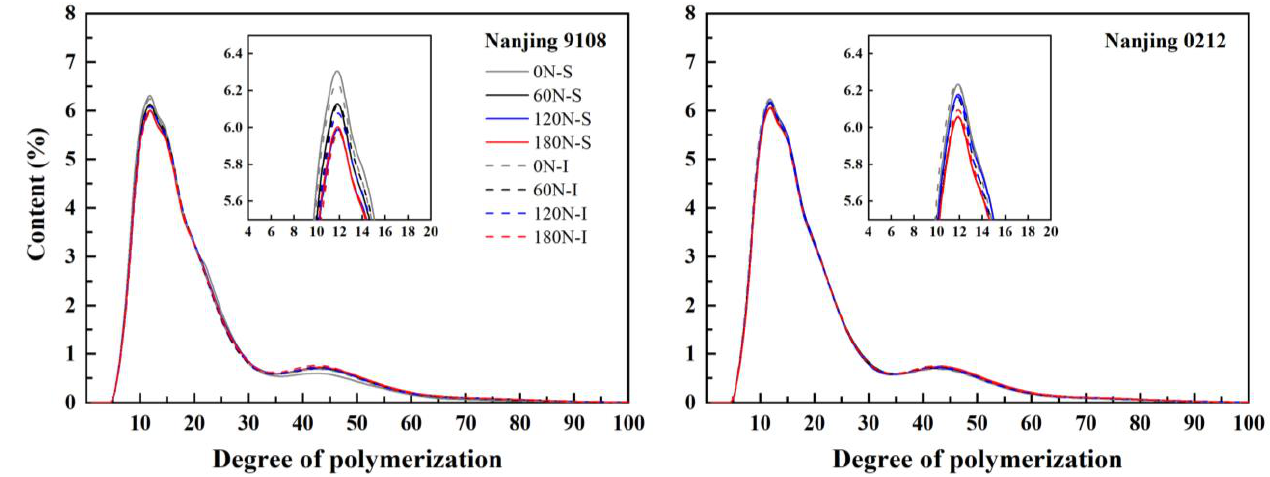
Figure 2. Amylopectin chain length distributions of superior and inferior grains of japonica rice under different PNF treatments.